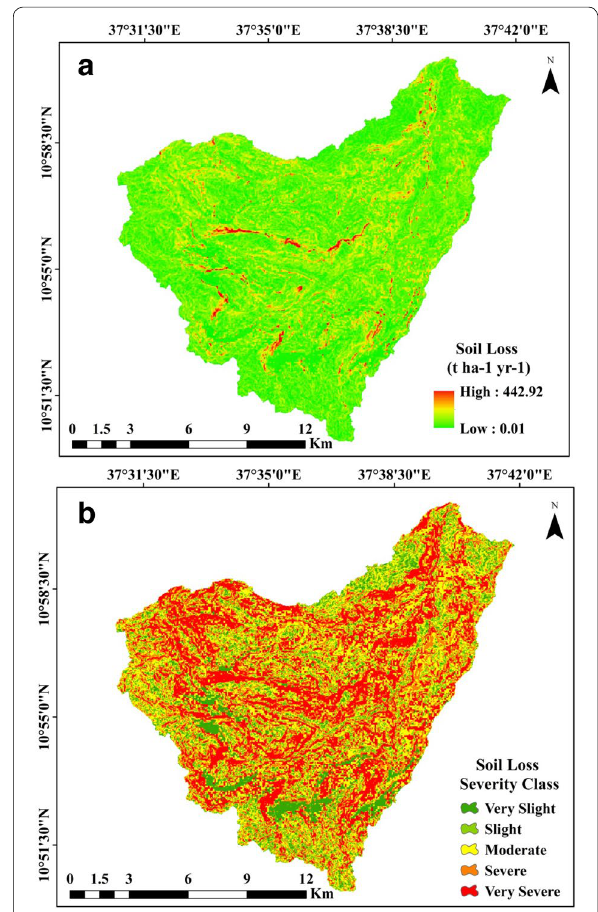
Fig. 5 Soil erosion map of Gumara watershed a potential soil loss (t ha